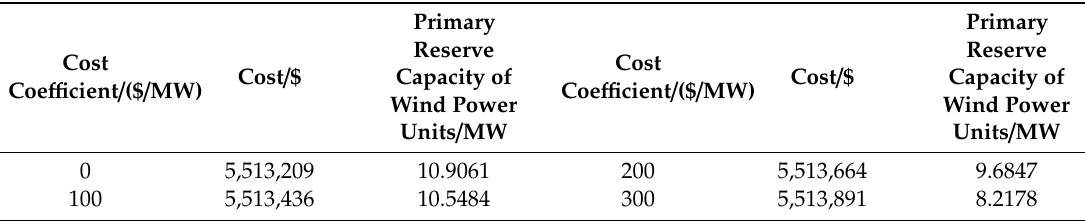
Table 2. Primary reserve cost and capacity of the wind power